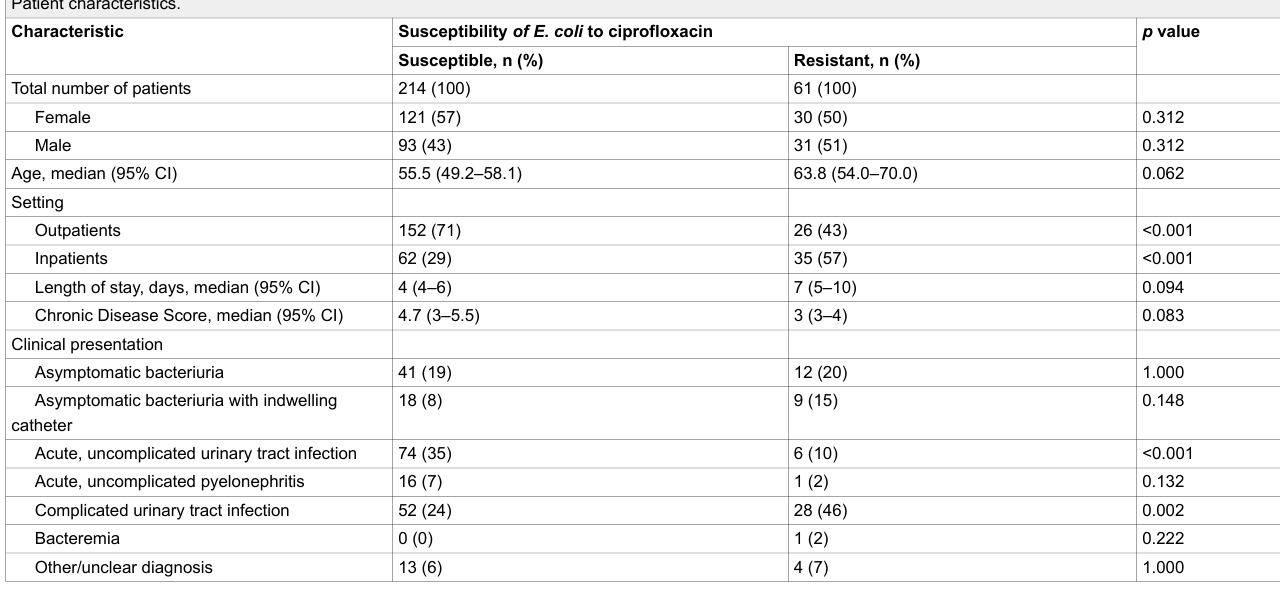
Table 2 Risk factors for urinary tract infections with ciprofloxacin-resistant E. coli